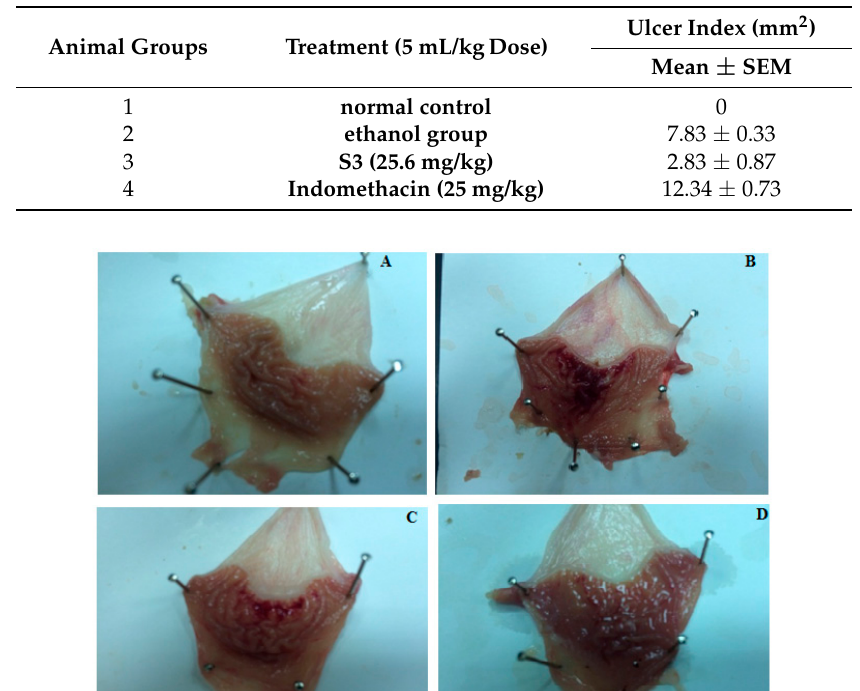
Figure 2. The ethanol-induced gastric ulcers after treatment with ( A ) normal control, ( B ) ethanol, ( C ) compound S3 (25.6 mg/kg) with ethanol and ( D ) indomethacin (25 mg/kg) with ethanol. PAS staining indicates the mucus secretion in the gastric glands. Figure 3. ( A ) Gastric section showing intact gastric mucosa of control rats. ( B ) Gastric section showing gastric mucosal ulceration consisting of necrosis, cellular debris neutrophils and degenerated epithelial cells of ethanol treated rats. ( C ) Gastric section showing focal mucosal ulceration consisting of predominantly neutrophils and degenerated epithelial cells of compound S3 (25.6 mg/kg) and ethanol treated rats. ( D ) Gastric section showing intense mucosal ulceration consisting of necrosis, cellular debris, neutrophils and degenerated epithelial cells of indomethacin (25 mg/kg) and ethanol treated rats.